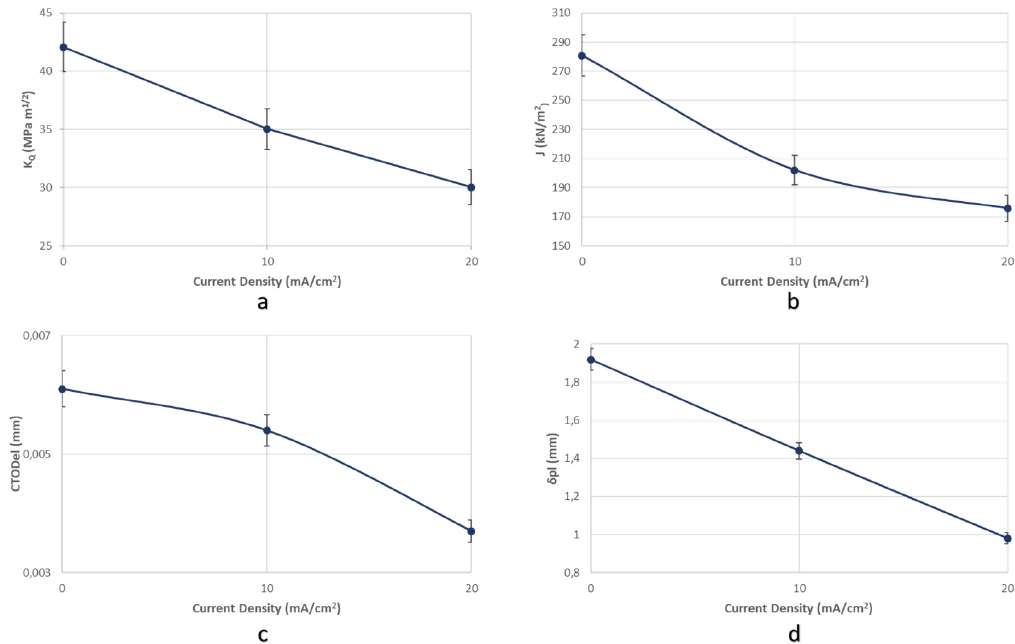
Figure 16. Reduction rate of the main toughness parameters ( a ) K Q , ( b ) J , ( c ) CTOD el , and ( d ) CTOD pl in function with the applied current density during the in situ hydrogen cathodic charging process and slow strain rate bending loading.